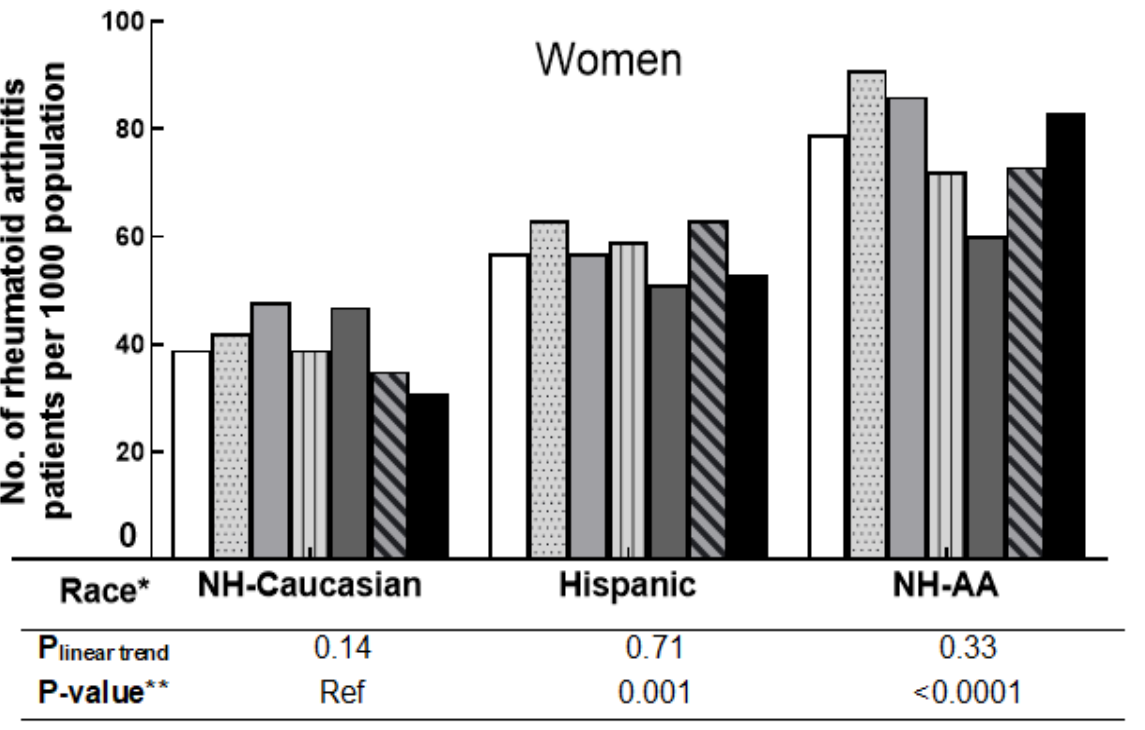
Figure 2. Age-adjusted prevalence of rheumatoid arthritis by race in men and women, 2005–2006 through 2017–2018. ( a ) shows the prevalence of men by race; ( b ) shows the prevalence of women by race. * includes the “other” race group not shown; ** p -value was based on F-test.